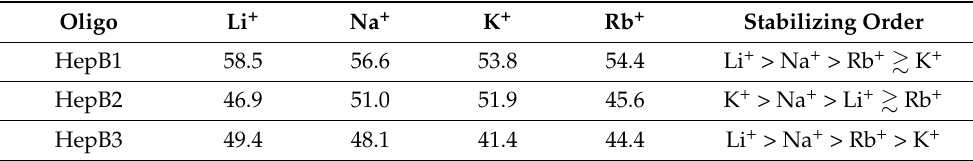
Table 2. Transition temperature (T m ) of the three studied HepB oligos in presence of different cations. The order of stabilizing ability is indicated as